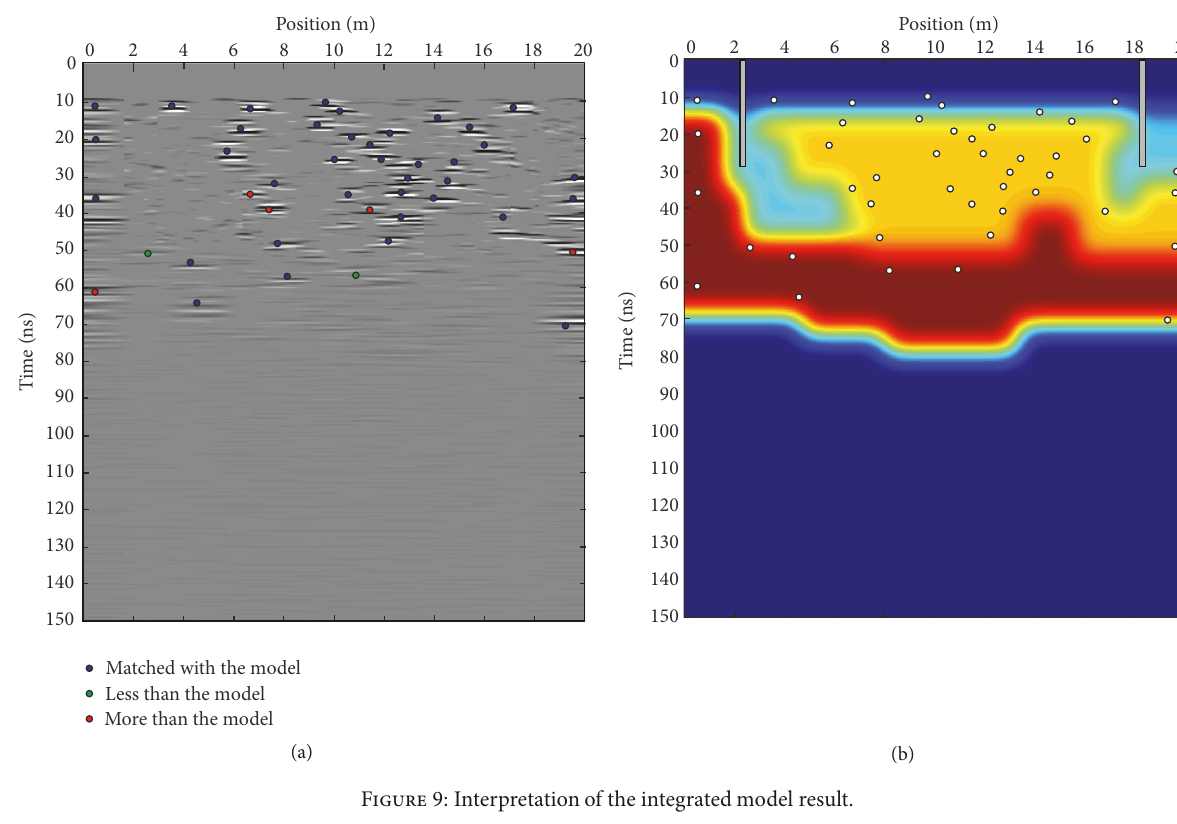
Figure 9: Interpretation of the integrated model